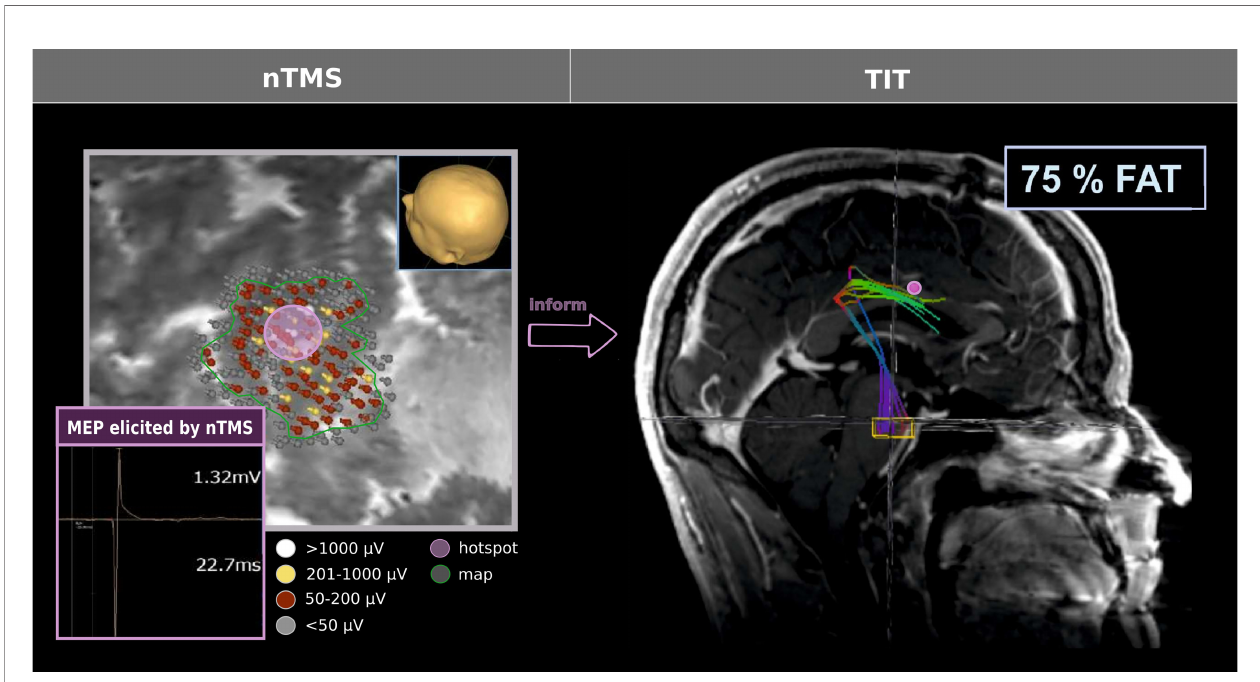
FIGURE 1 | TIT work fl ow. nTMS was performed to achieve a functional map of the respective somatotopic area (here: hand representation). All map coordinates (corresponding to MEP of ≥ 50 m V peak-to-peak amplitude, i.e., labelled in red, yellow, or white) and the centre/hotspot coordinate (yielding the highest reproducible peak-to-peak amplitude; violet) were exported to inform tractography, serving as starting points for the deterministic algorithm. Notably, the centre/hotspot was enlarged by 5 mm; a second cubic region of interest was set in the anterior pontine region [yellow box; cf. Weiss Lucas et al. (15)]. Tractography was performed by adjusting the cut-off of fractional anisotropy values to the 75% of the fractional anisotropy threshold [FAT, according to Frey et al. (79)], exempli fi ed here with the map centre/hotspot serving as the